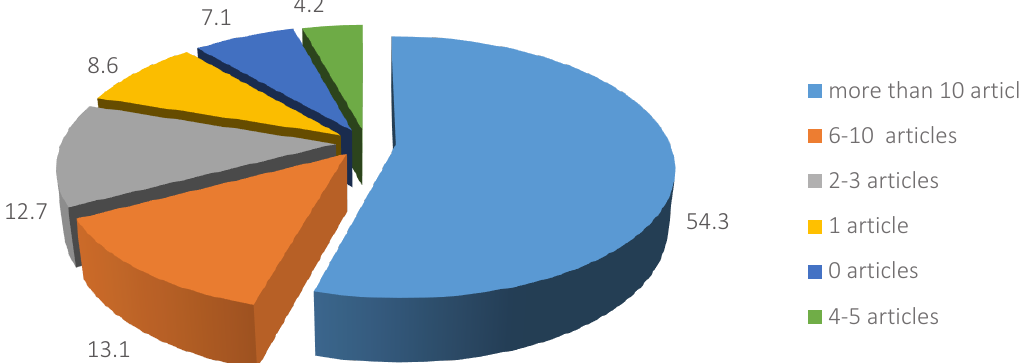
Figure 1. Percentage of scientists who have articles in Ukrainian scientific journals not indexed by Web of Science and (or)